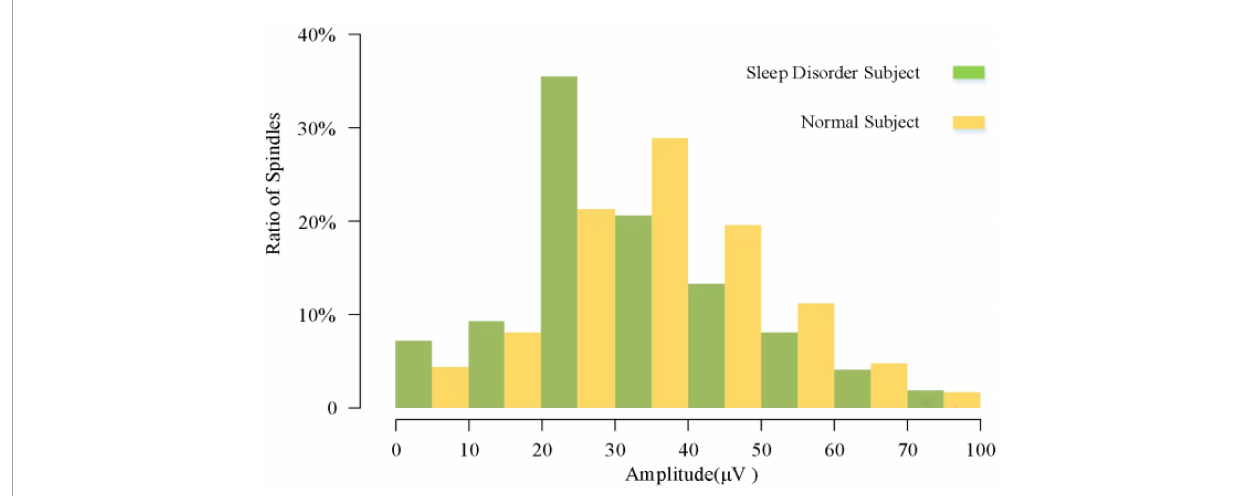
FIGURE8 Overall spindle amplitude distribution of sleep-disordered subjects and normal subjects.